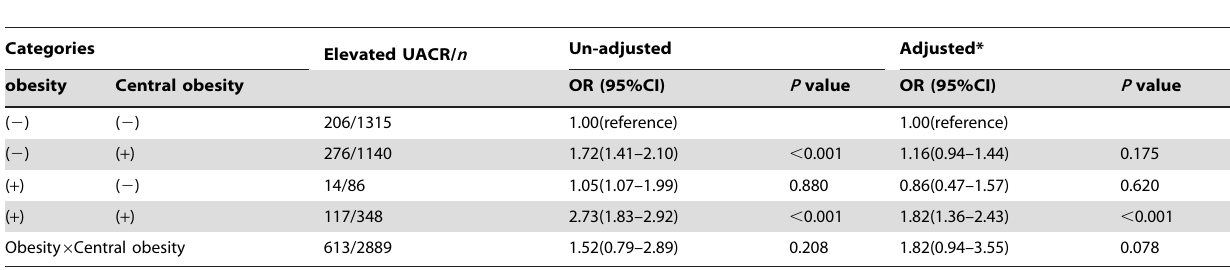
Table 3. Interactive effect analysis of obesity and central obesity on elevated urinary albumin-to-creatinine